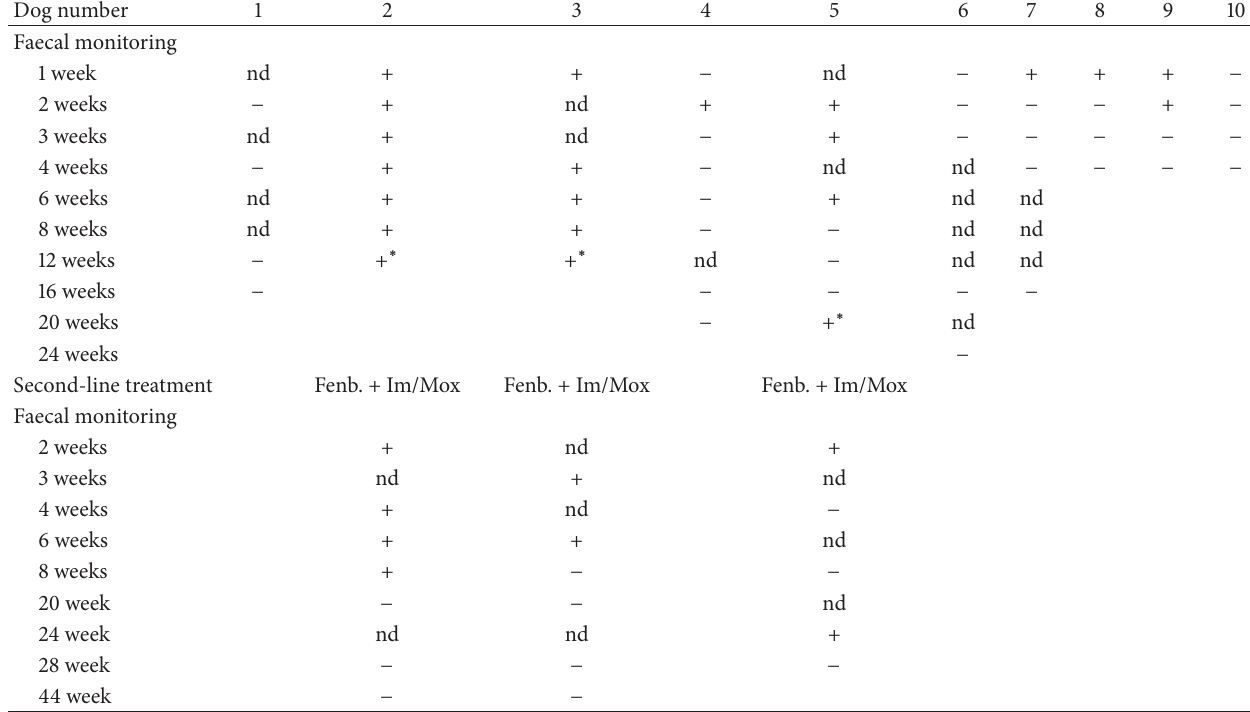
Table 4: Results of faecal monitoring by Baermann’s test. The asterisks show the passage to a second-line treatment (fenbendazole 25 mg/kg/os/daily for 21 days plus Im/Mox spot-on once a month) for dogs 2, 3, and